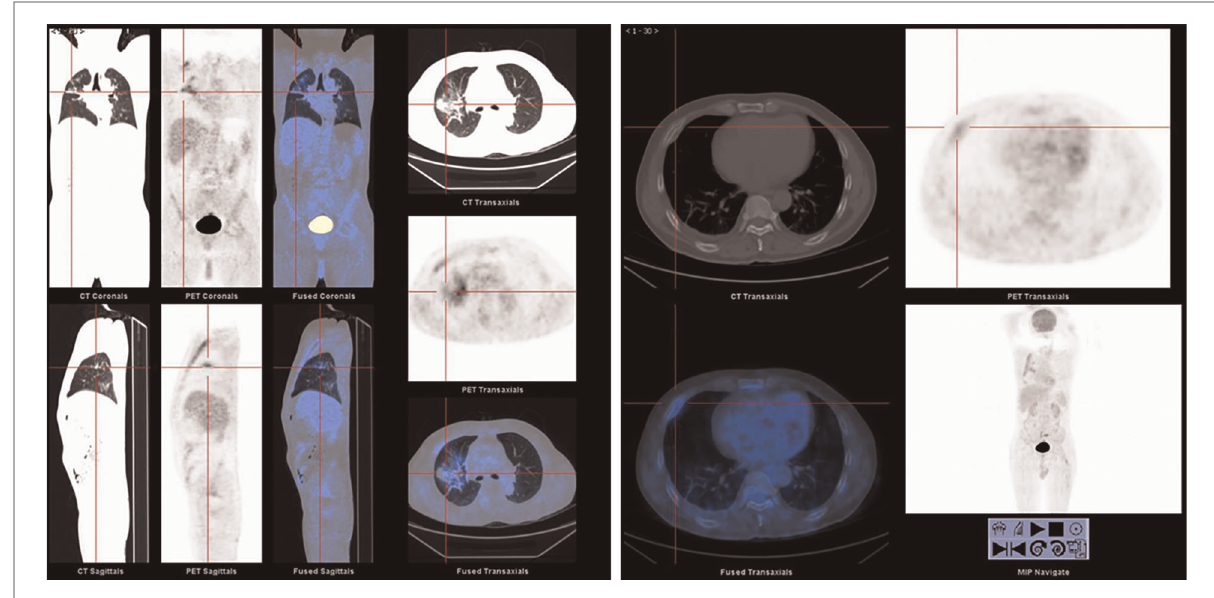
FIGURE 2 PET-CT images of primary mucinous lung adenocarcinoma with rib